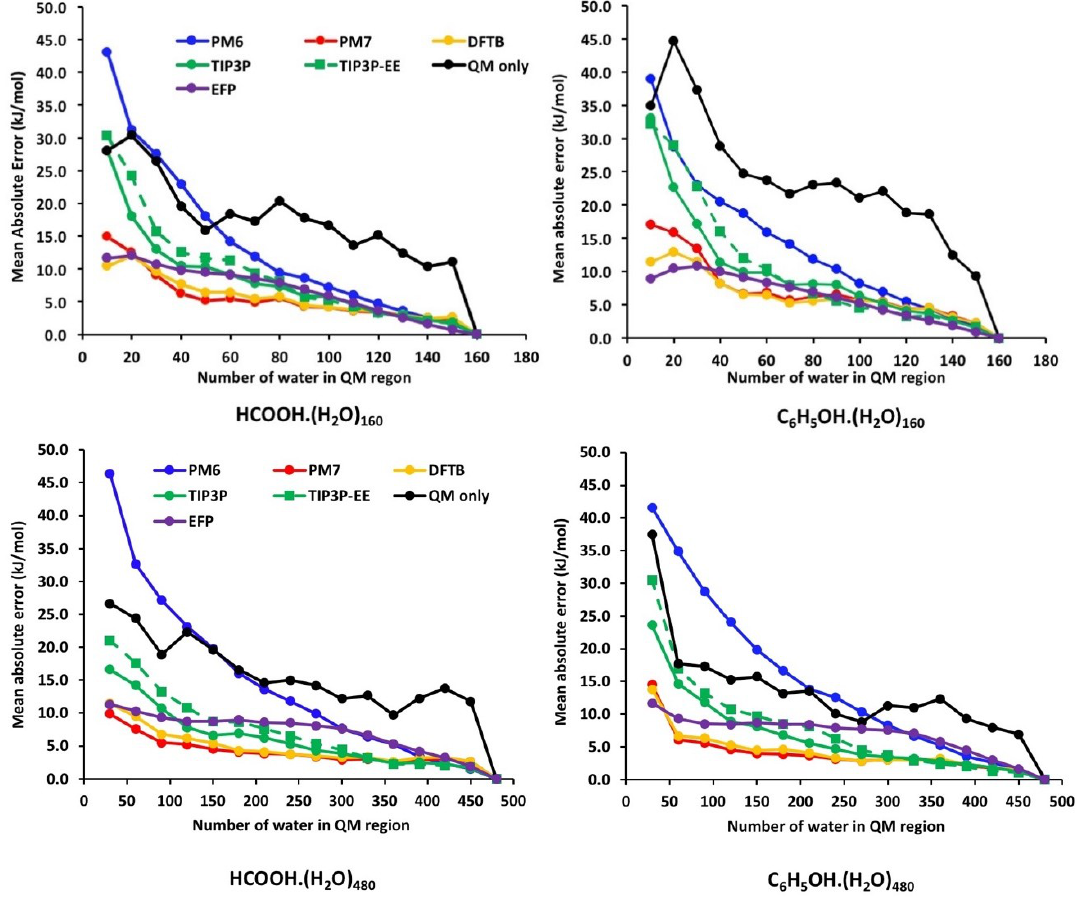
Figure 4. Error convergence profiles for the various QM/MM and QM/QM′ models as a function of QM region size for 160-water cluster ( top ) and 480-water cluster ( bottom ) of neutral acids.